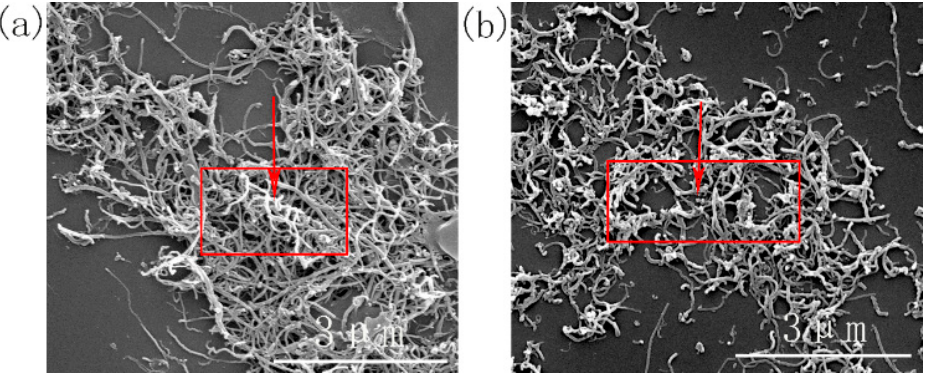
Figure 1. The morphology of ( a ) pristine CNTs and ( b ) f -CNTs.